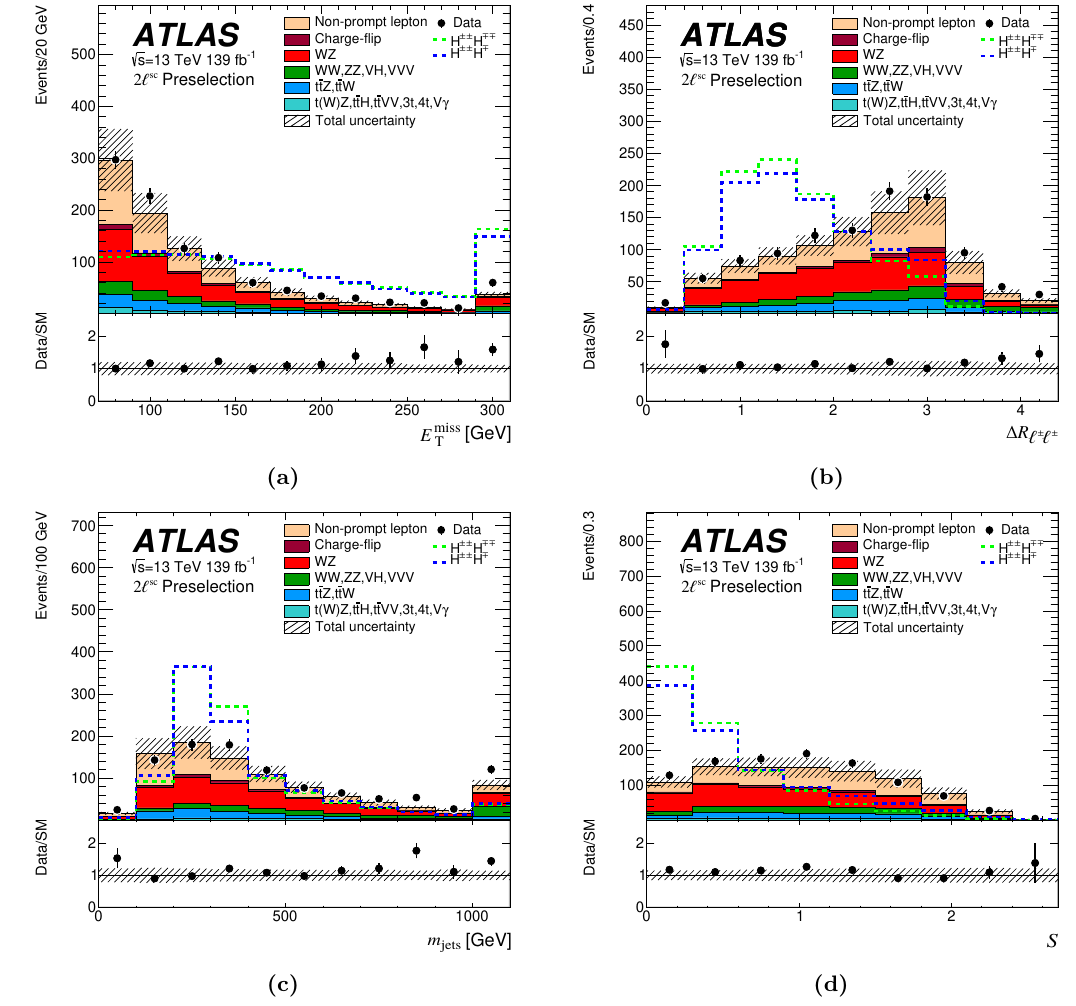
Figure 3 . Distribution of selected variables used to define the 2 ‘ sc SRs. The events are selected with the preselection requirements listed in table 4. The data (dots) are compared with the expected contributions from the relevant background sources (histograms). The expected signal distributions for m = 300 GeV are also shown, scaled to the observed number of events. The last bin includes H ±± overflows. In each figure the bottom panel shows the ratio of data to the estimated background. The hatched band around unity represents the total uncertainty of the